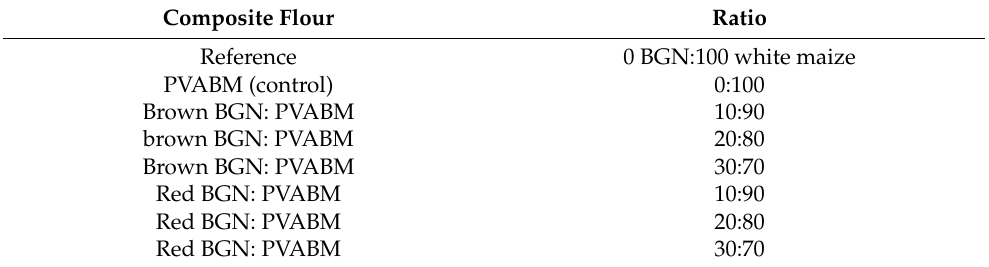
Table 1. The weight-to-weight ( w / w ) ratios of the BGN–PVABM composite instant flours. Composite Flour